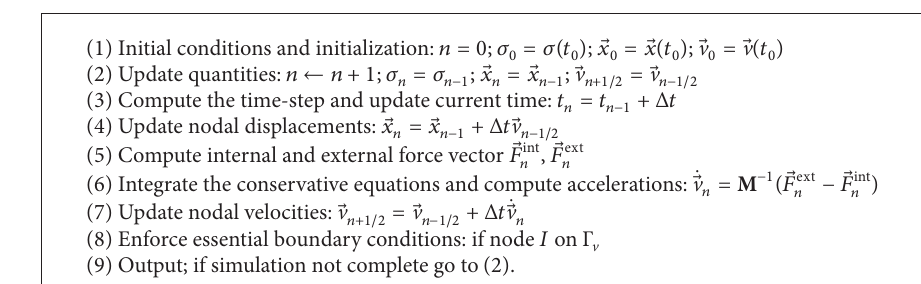
Figure 6: Von Mises stress when the die strokes.